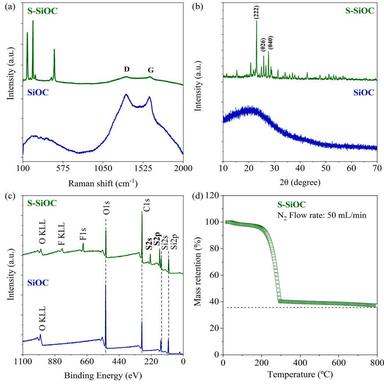
(a) Raman spectra of the SiOC and S-SiOC powders. Laser wavelength: 785 nm (1.58 eV), Exposure time: 20 s, accumulations: 2, laser power: 5 %, lens: 50 ×. (b) XRD patterns, and (c) XPS survey spectra of the SiOC and S-SiOC powders. (d) TGA of the S-SiOC powder.